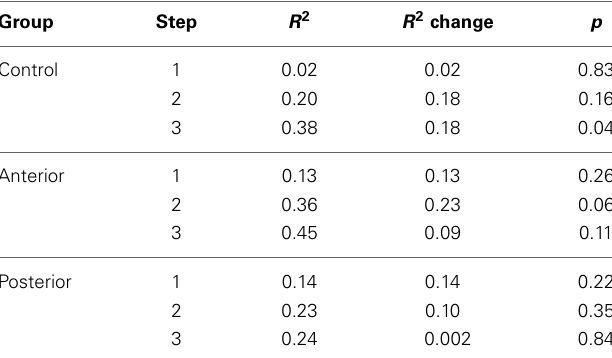
Table 3 | Hierarchical regression models predicting choices in Th + A vs. Th-A